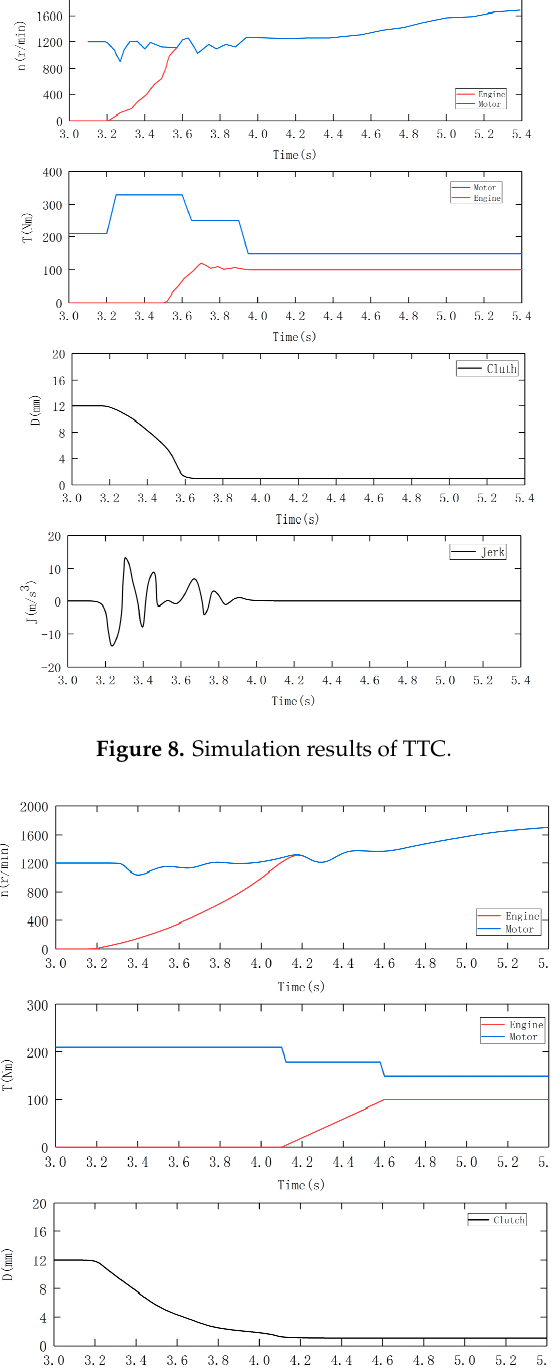
Figure 9. Simulation results of MPC.